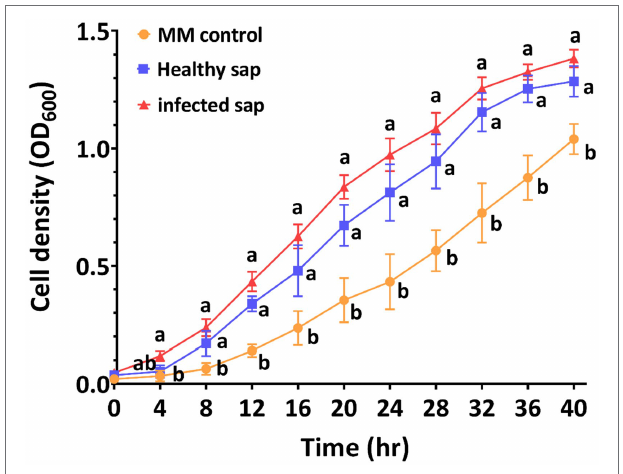
FIGURE 5 | Xylem sap from infected tobacco cultivar Yunyan87 improves R. pseudosolanacearum growth in vitro . R. pseudosolanacearum growth curves in minimal medium or minimal medium supplemented with xylem sap extracted from healthy/infected tobacco. Each bar represents the mean ± SE of three replicas. Different letters indicate xylem sap treatment and control treatment were significantly different ( p <